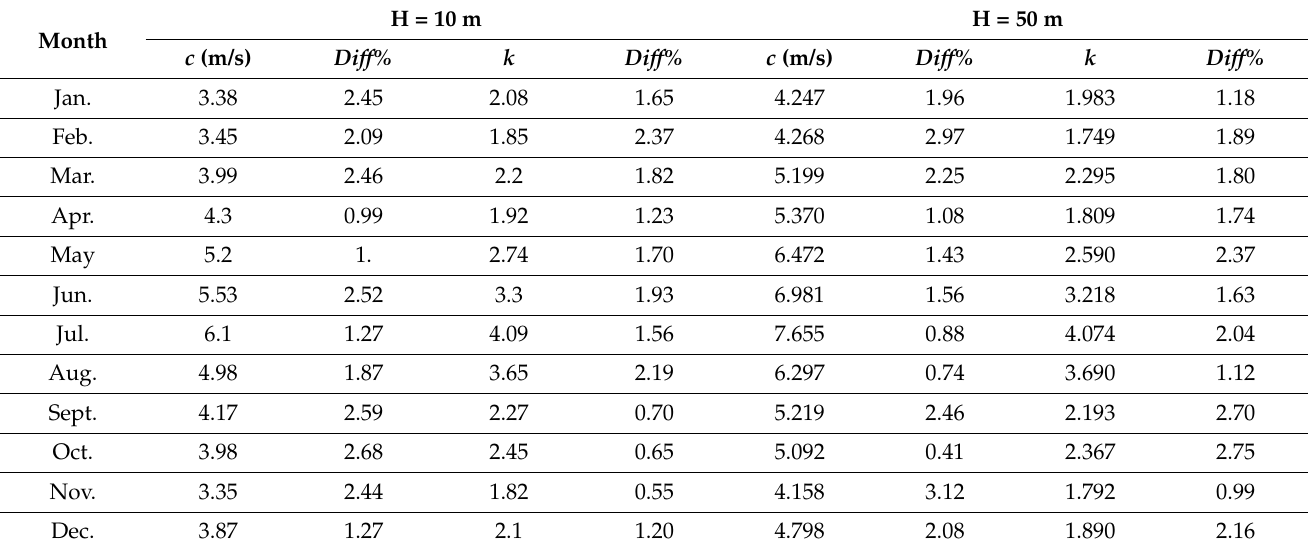
Table 2. The Weibull parameters by MATLAB, R 2 , Pw for RAWA city at 10 m and 50 m height, 2017.